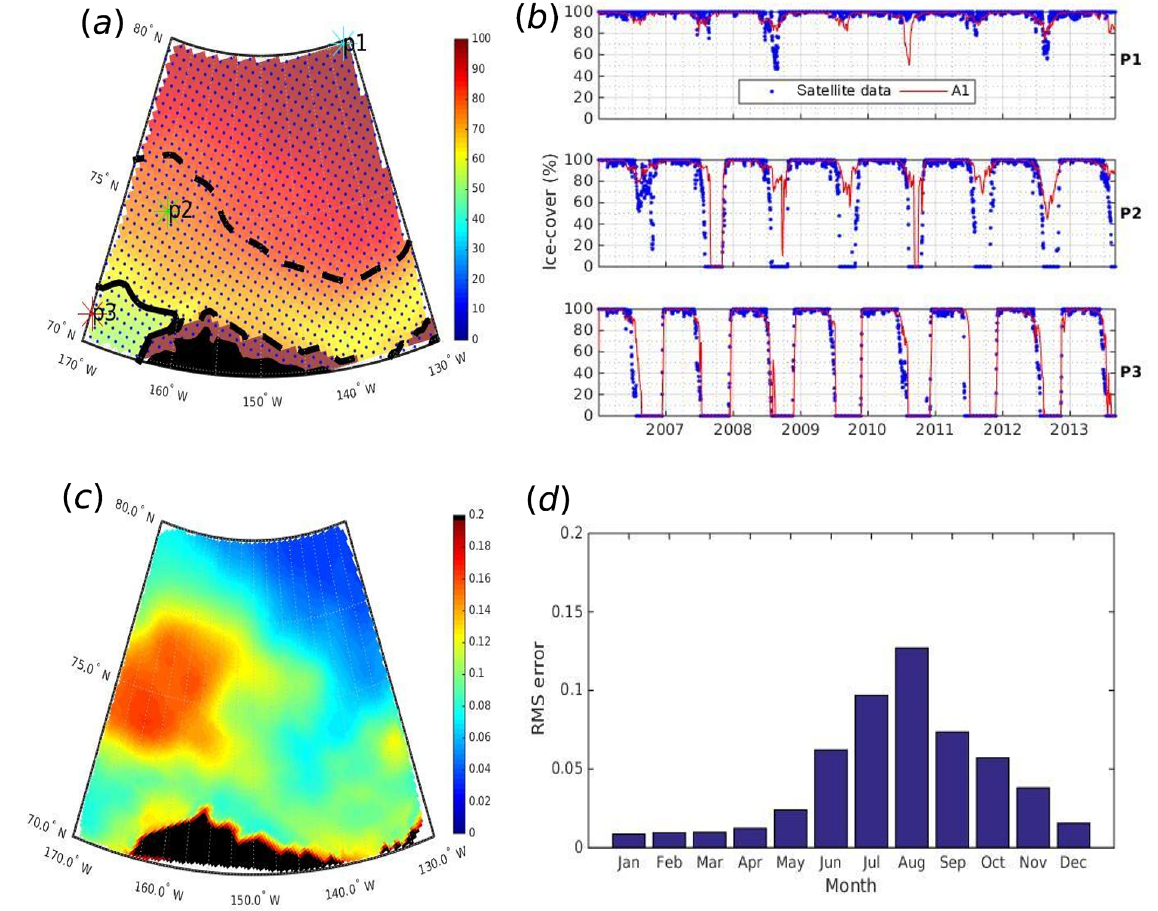
Figure 3. (a) Averaged satellite sea ice cover from 2006 to 2013, with the solid black line marking 60% cover and dashed black line marking 80%; blue dots show the analysis grid, stars show the location of the three points Cyan P1, Green P2 and Red P3 where time-series data is graphed in (b) . (b) Time history of sea ice fraction from top P1, P2 and P3, with satellite data represented by blue dots, compared with A1. (c) Horizontal distribution of RMS error of A1 sea ice concentration averaged over time from 2006 to 2013; black mask covers the grid points on the land. (d) Spatially averaged annual RMS error of A1 sea ice